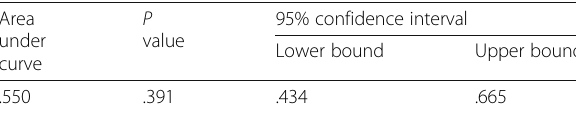
Table 12 AUC and P value for albumin for detection of neurological dysfunction Area under